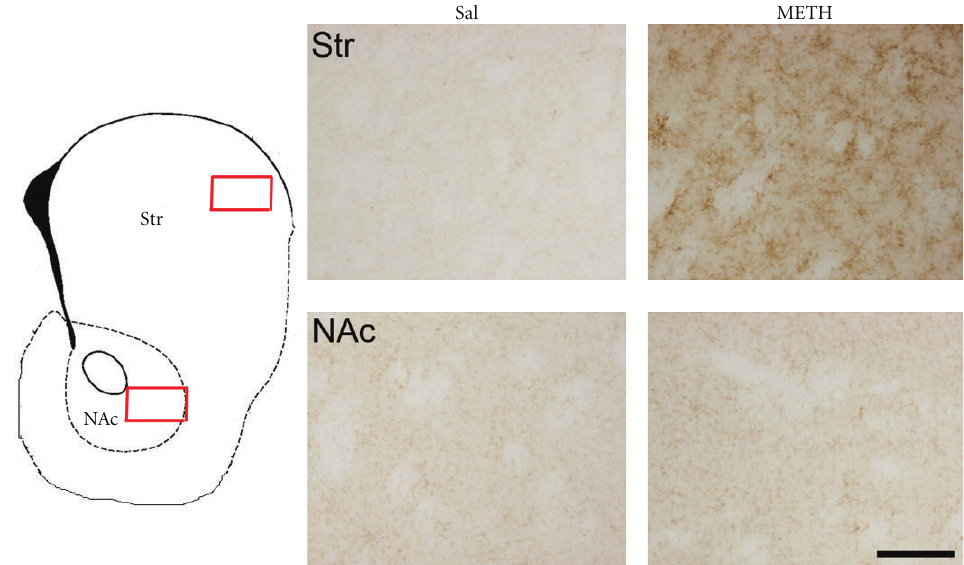
Figure 4: Metamphetamine produces microglial activation in mouse striatum (Str) but not in nucleus accumbens (NAc). Photomicrographs of sections of Str and NAcc of mice treated with saline or metahmphetamine (5mg/kg × 3) stained for Mac-1. Animals were killed 1 day after methamphetamine treatment for Mac-1. Bar indicates 100 𝜇 m.